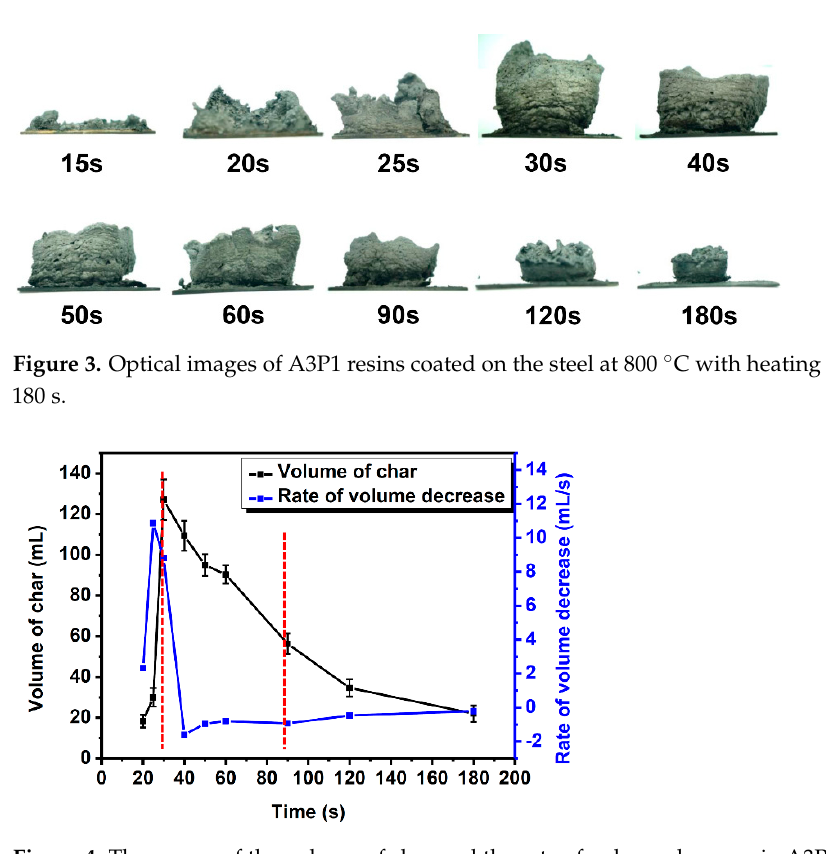
Figure 4. The curves of the volume of char and the rate of volume decrease in A3P1 resins.